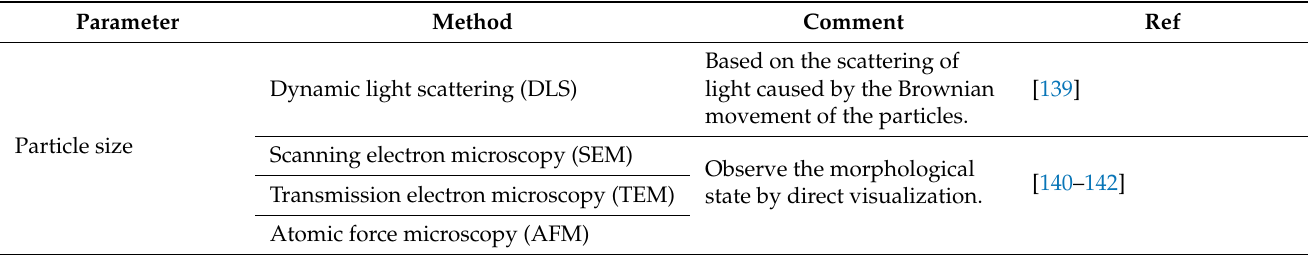
Table 3. General characterization techniques of